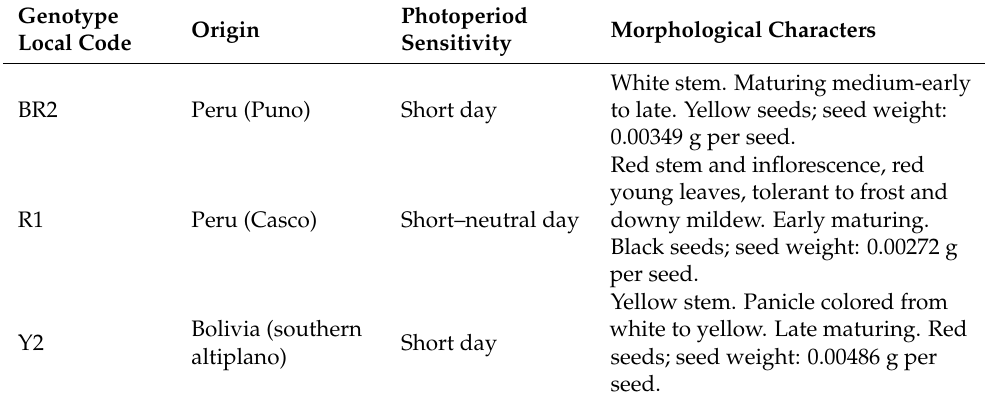
Table 2. Origin and characters of quinoa cultivars used in the experiment. Photoperiod Genotype Morphological Characters Origin Sensitivity Local Code White stem. Maturing medium-early BR2 Peru (Puno) Short day to late. Yellow seeds; seed weight: 0.00349 g per seed. Red stem and inflorescence, red young leaves, tolerant to frost and downy mildew. Early maturing. R1 Peru (Casco) Short–neutral day Black seeds; seed weight: 0.00272 g per seed. Yellow stem. Panicle colored from white to yellow. Late maturing. Red Bolivia (southern Short day Y2 seeds; seed weight: 0.00486 g per altiplano)